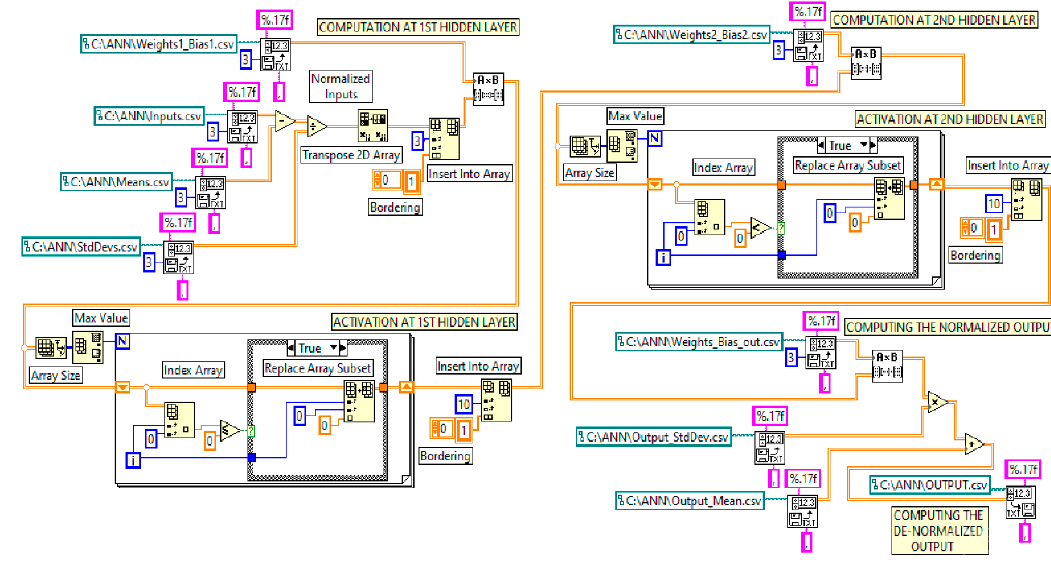
Figure D1. The LabVIEW diagram of the dedicated VI test. Figure A5. The LabVIEW diagram of the dedicated VI test.